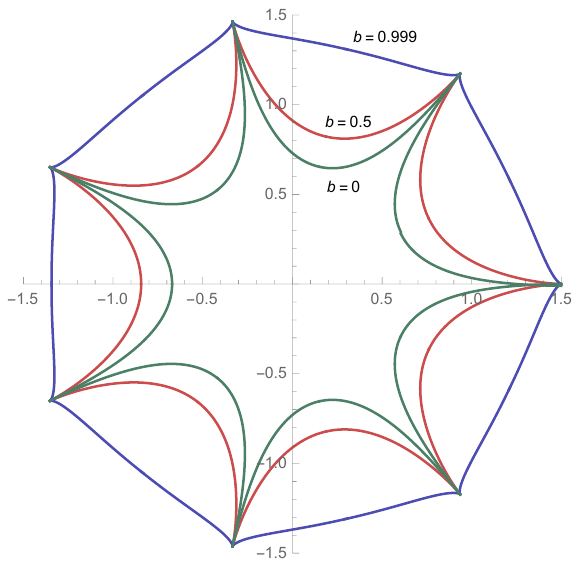
Figure 4. Closed spiky string pro(cid:12)le with n = 7 spikes in AdS space with di(cid:11)erent values of the (cid:13)ux parameter b . Here, the cusp position has been (cid:12)xed at (cid:26) 1 = 1 :